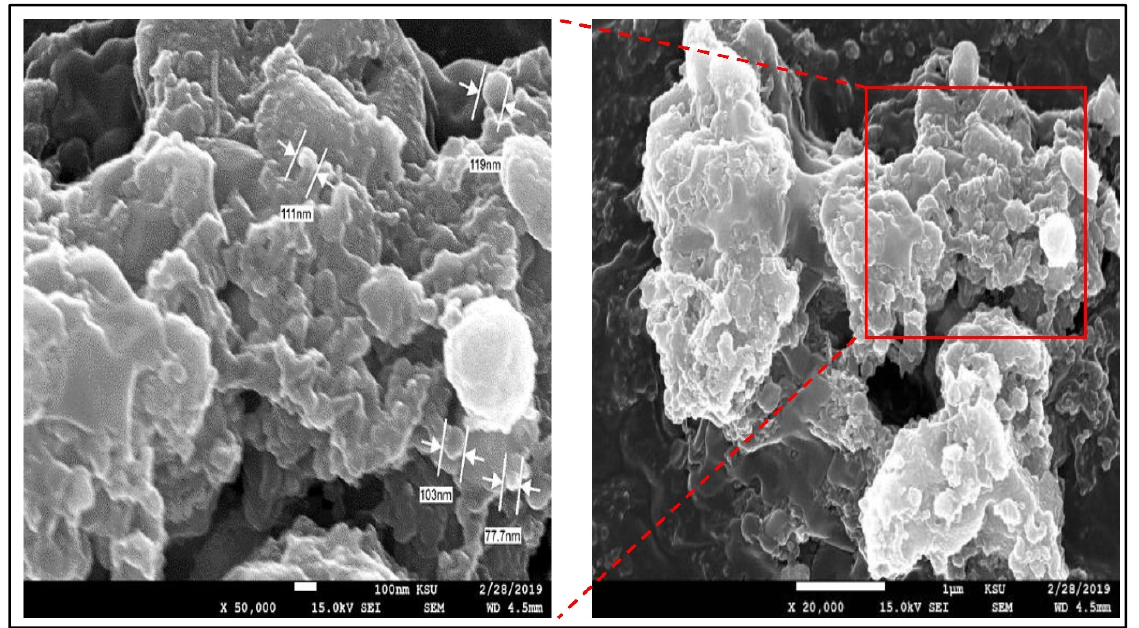
Figure 3. The FE-SEM imaging of GSE-AgNPs. A total of 8 μ L were loaded on the 200 mesh grids with a carbon support film of JEOL JEM-2100 microscope. JEM-2100 optic system with 15 kV was used to capture the SEM images at the magnification powers of 20,000× ( right ) and 50,000× ( left ).